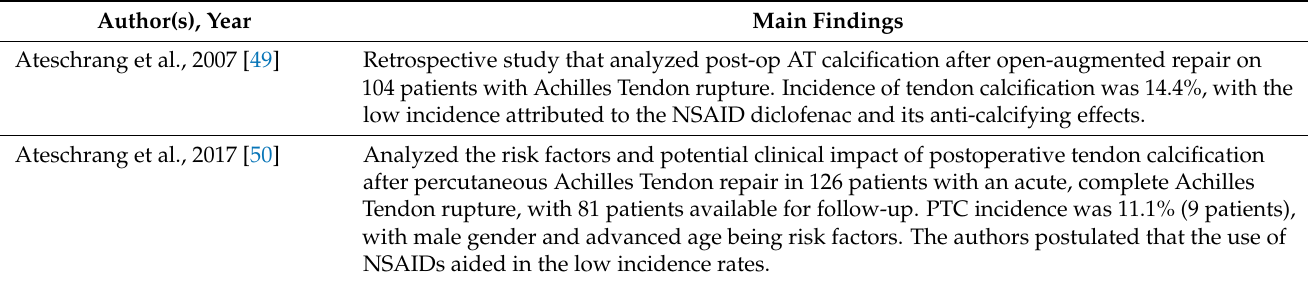
Table 6. Relevant articles (Clinical Studies; 2007, 2017) and their main findings.